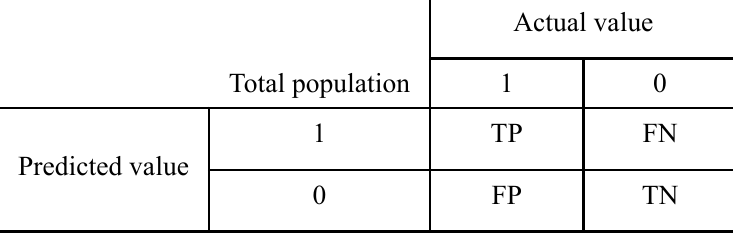
Figure 2. Confusion